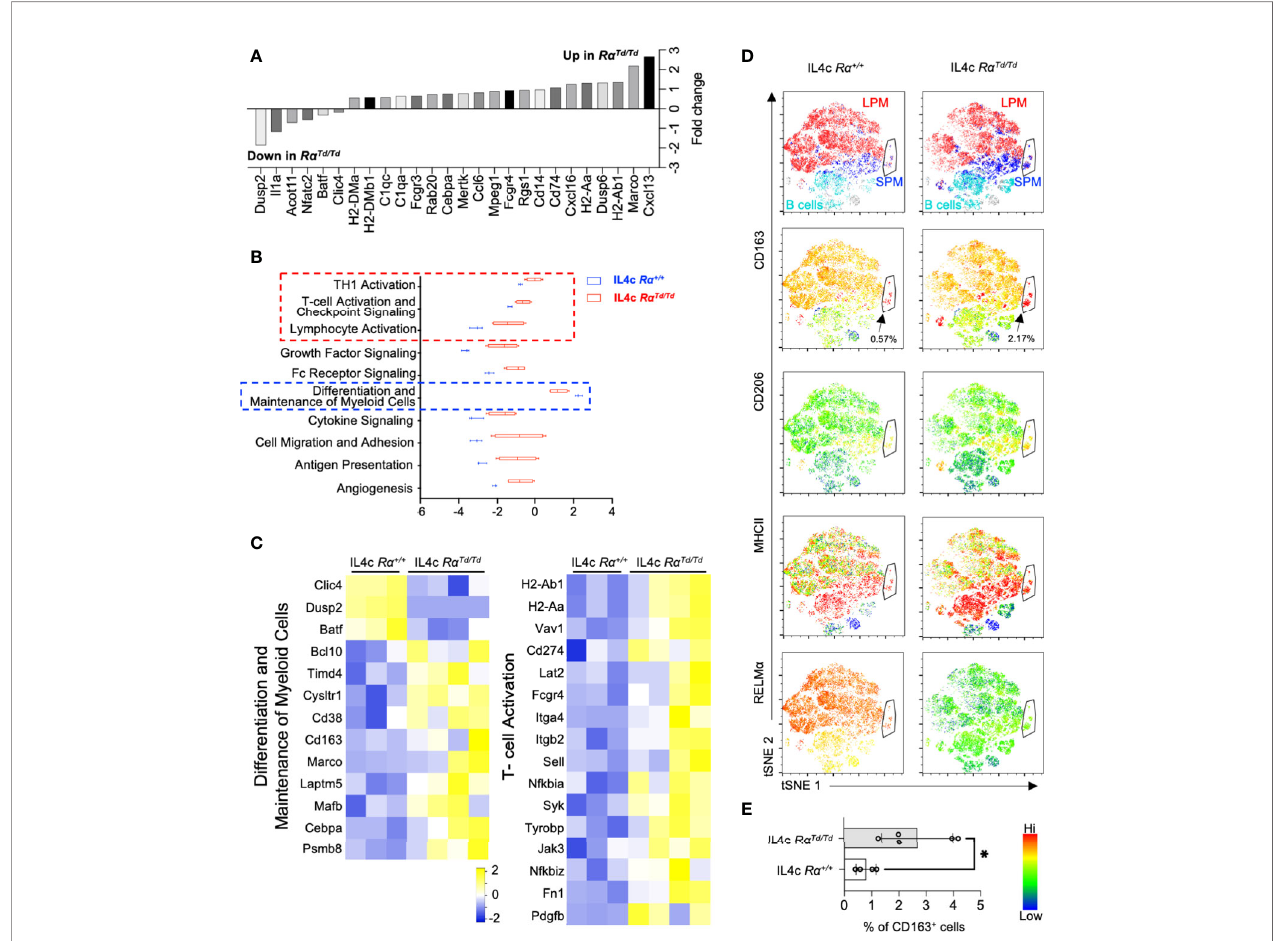
FIGURE 4 | RELM a -de fi cient M2 macrophages exhibit a hyperactivated macrophage phenotype. Differential expression of genes associated with functional pathways was evaluated in macrophages sorted from IL-4c injected R a +/+ or R a Td/Td mice. (A) Genes with highest Log2 fold change differences between IL4c injected R a +/+ and IL4c R a Td/Td identi fi ed by Nanostring advanced analysis (p < 0.05). (B) Advanced pathway analysis performed on IL4c R a +/+ and IL4c R a Td/Td macrophage RNA reveals signi fi cantly increased or decreased pathway scores (p<0.05). (C) Heatmap of differentially expressed genes within the functional pathways. (D) t-SNE-guided fl ow cytometry analysis of peritoneal cell subsets (LPM, red; SPM, blue; B1 cell, cyan). Black arrow and outline indicate a separate subset with SPM and LPM characteristics. Subsets were evaluated for expression of CD163, CD206, MHCII and RELM a . (E) Frequency of CD163 + macrophages in IL4c-treated R a +/+ and R a Td/Td mice. *, p ≤